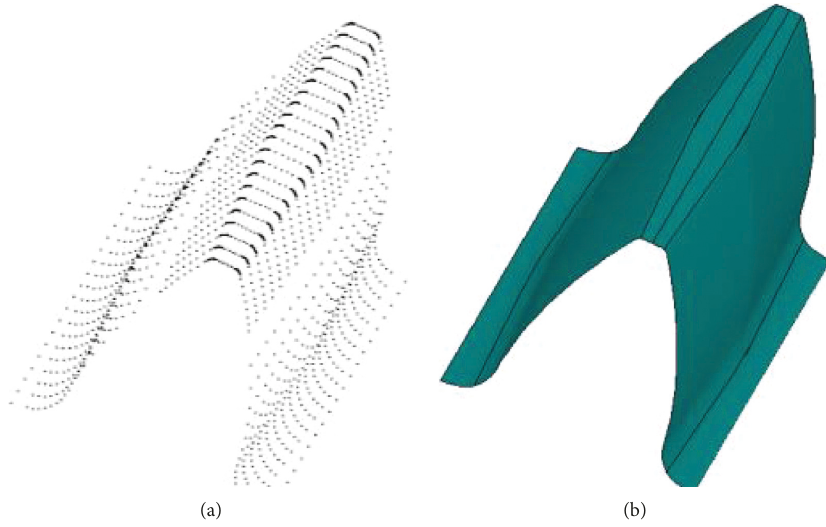
Figure 2: Fitting tooth surface. (a) Grid lattice of a single tooth surface. (b) Tooth surface.